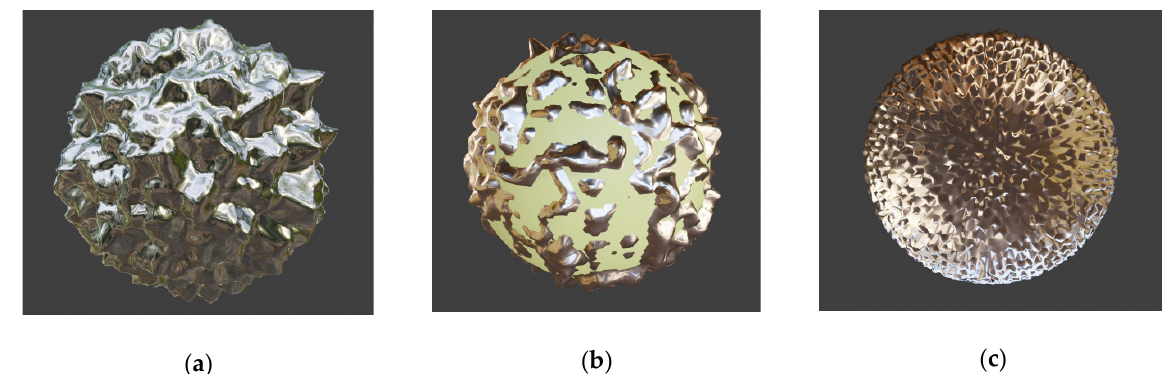
Figure 8. Calottes with templated reliefs corresponding to Turing patterns of diffusion; ( a ) diffusion reaction lines; ( b ) diffusion reaction dots; ( c ) complex Turing diffusion reaction pattern.